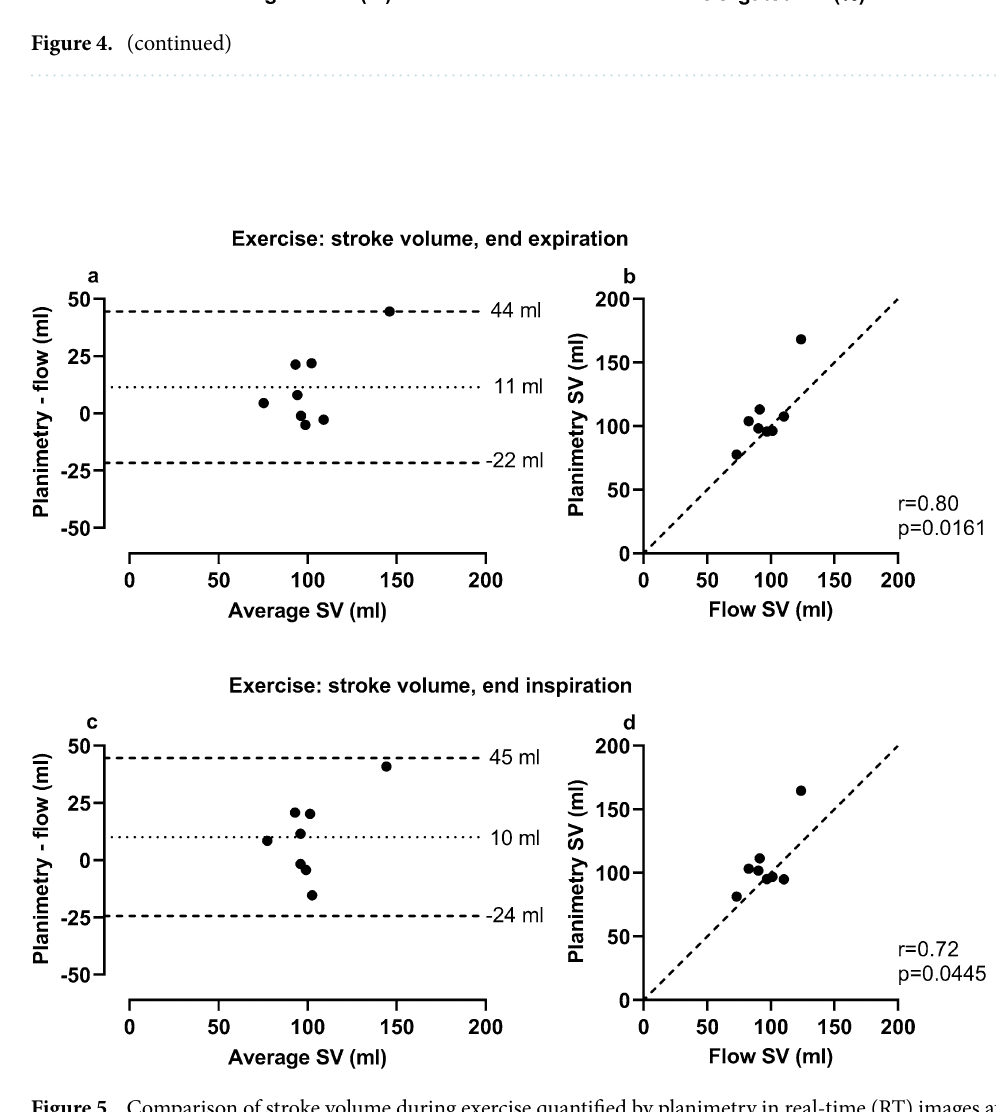
Figure 5. Comparison of stroke volume during exercise quantified by planimetry in real-time (RT) images at end expiration and end inspiration to flow in RT CMR images. Planimetric RT measurements were made in stacks with an ~ 8 s image acquisition time per slice (250 time-frames). Bias was low for left ventricular stroke volume (SV) when comparing planimetric measurements in RT CMR images with flow measurements in the ascending aorta in RT phase-contrast images in eight healthy volunteers. The outlier in each plot represents the same healthy volunteer in which stroke volume measured from flow was lower than from planimetry. No apparent irregularities in either modality were found in this individual. In the Bland–Altman plots the dotted line represents bias, defined as the mean difference between planimetric and flow measurements, and the dashed lines represent the upper and lower 95% limits of agreement (bias ± 1.96 SD). In the scatter plots the dashed line represents a line of